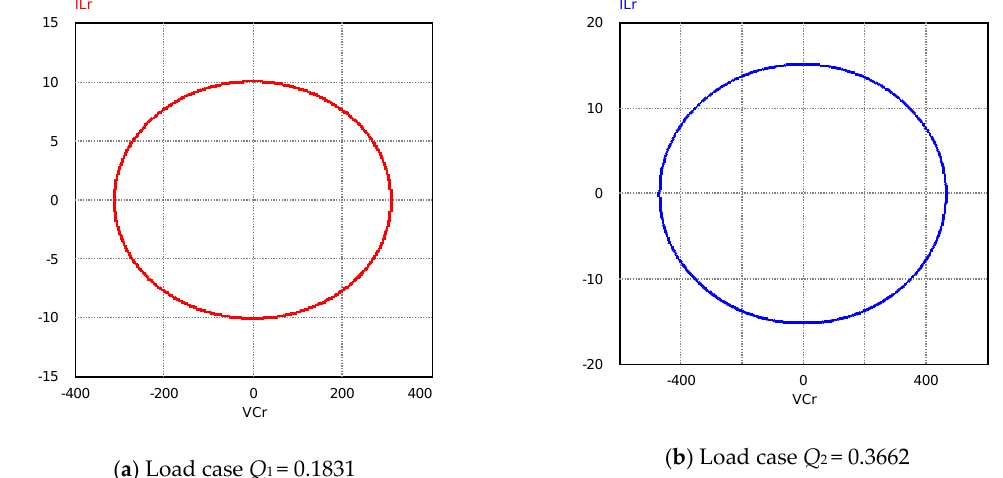
Figure 6. PSIM simulation results of the state-trajectories at resonant frequency.